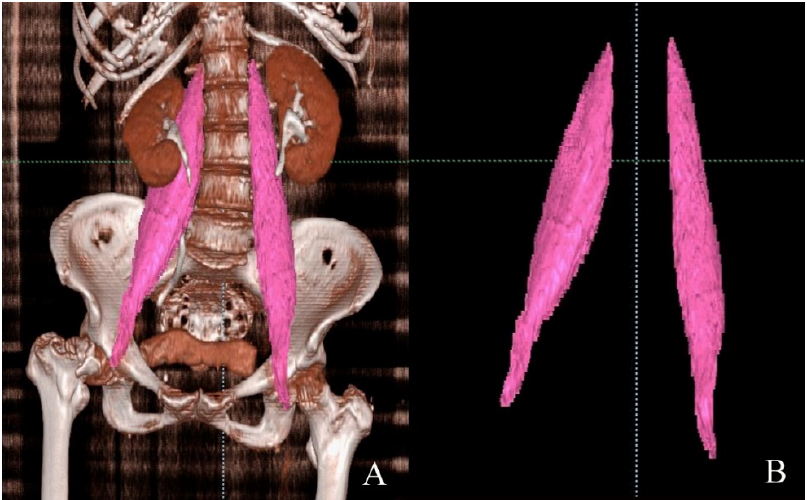
Figure 3. Segmentation of the psoas muscle and measurement of the psoas muscle volume. ( A ) Segmented psoas muscle after manual marking at the margin of the psoas muscle at all axial cuts from the twelfth thoracic vertebra to the lesser trochanter. ( B ) Isolation of psoas muscle from adjacent tissues.